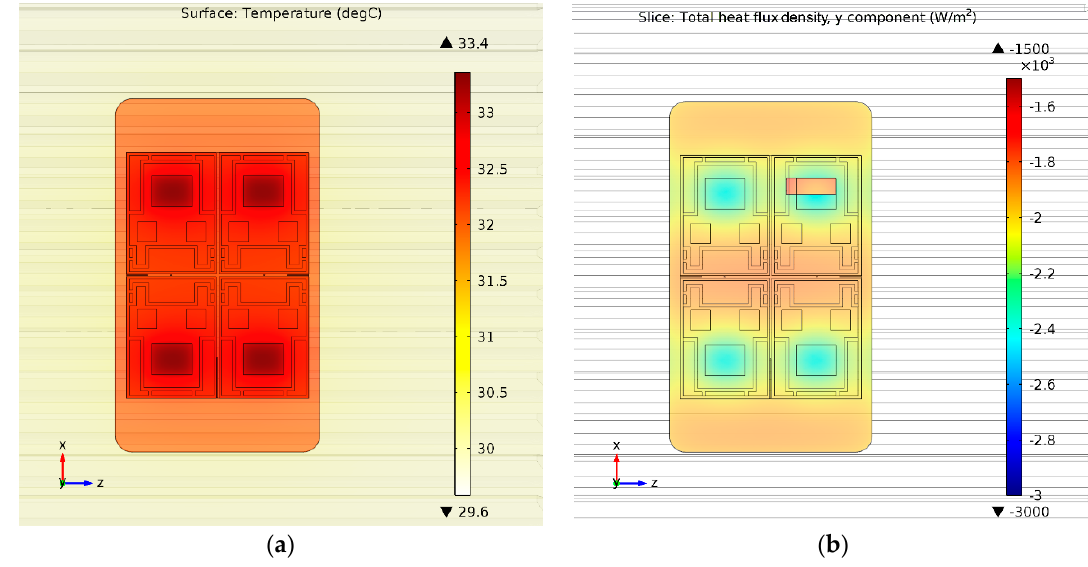
Figure 5. Top view of the model: ( a ) temperature distribution; ( b ) heat flux density distribution.